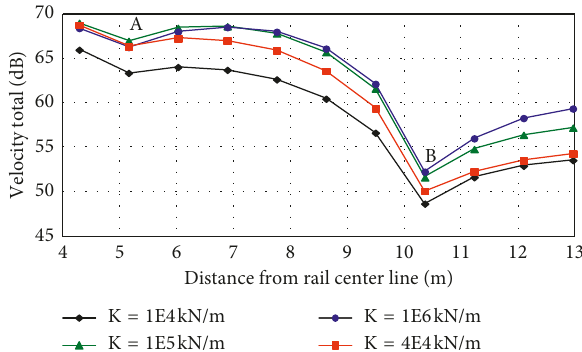
Figure 10: Finite element results for the vibration total dB (equation (8)) changing with the distance from the rail centerline under a rail pad damping of 10kN s/m (where K is the rail pad · stiffness and the rail pad interval is 1.3m).